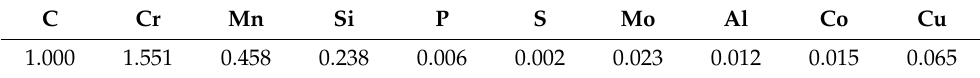
Table 1. Chemical composition of AISI 52,100 bearing steel [wt.